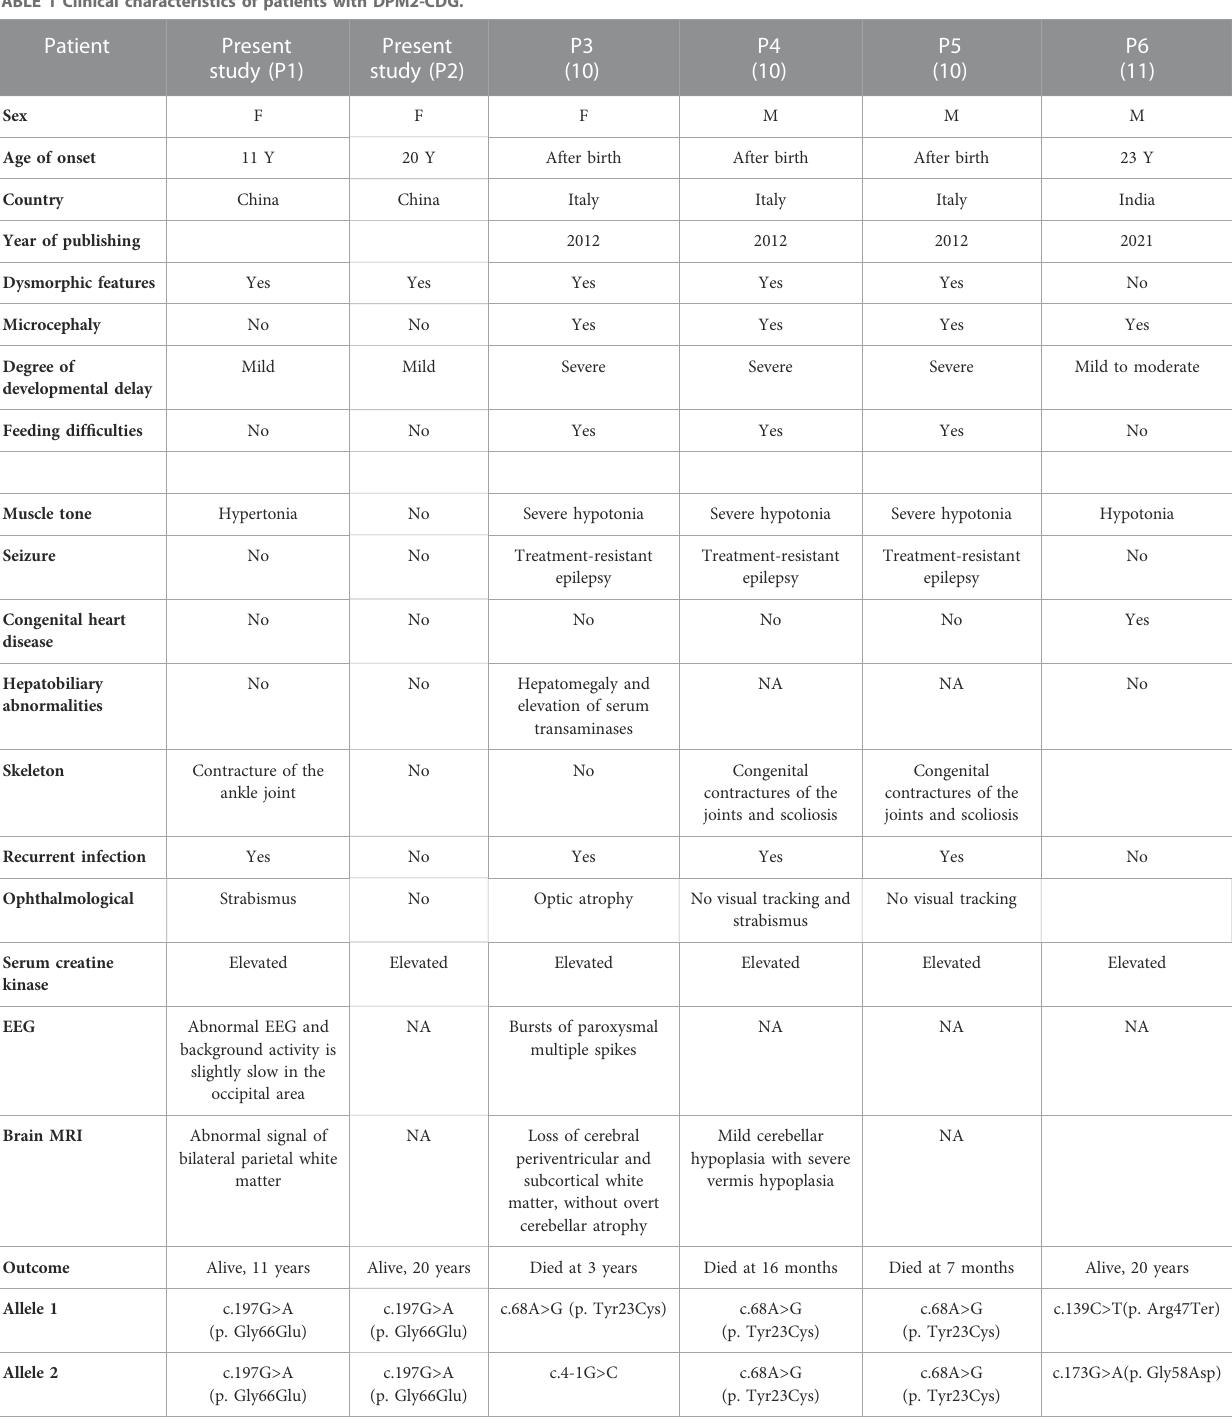
TABLE 1 Clinical characteristics of patients with